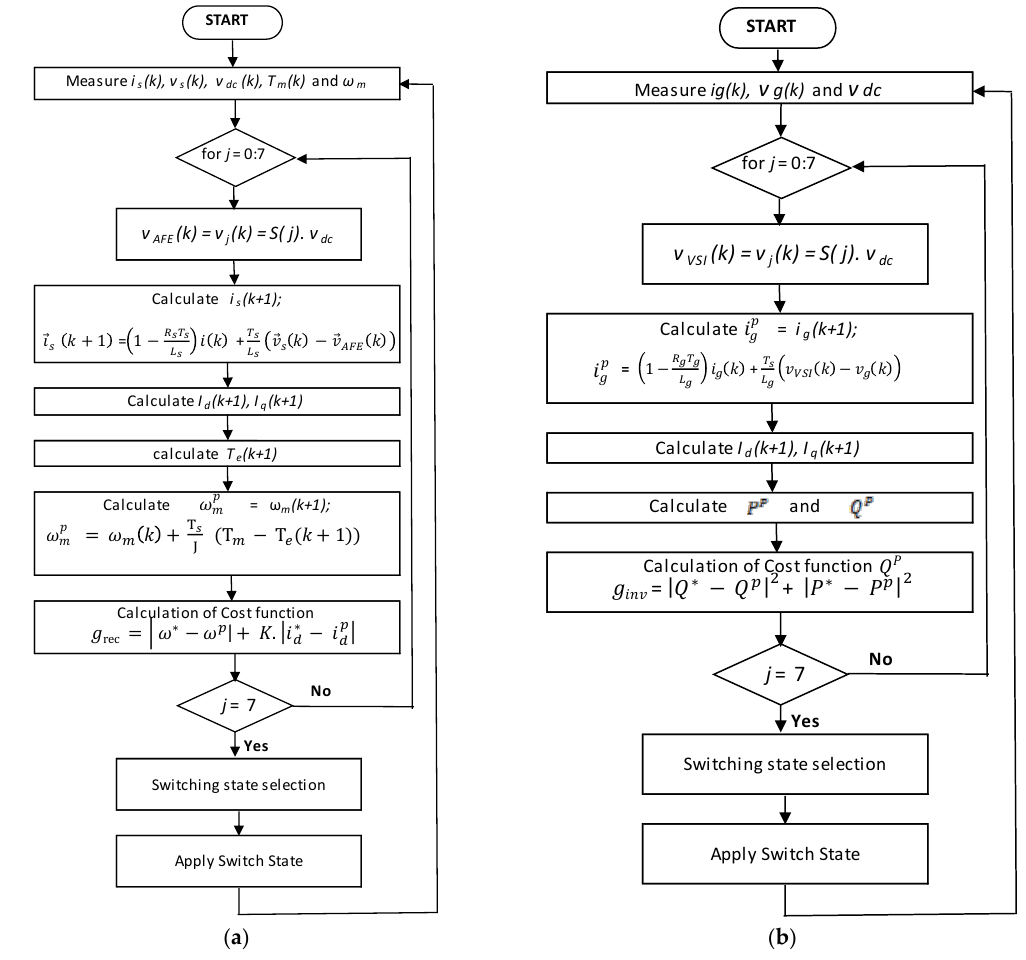
Figure 5. ( a ) MPC algorithm flow chart for the AFE rectifier; ( b ) MPC algorithm flow chart for the grid-connecting 2L-VSI Inverter.